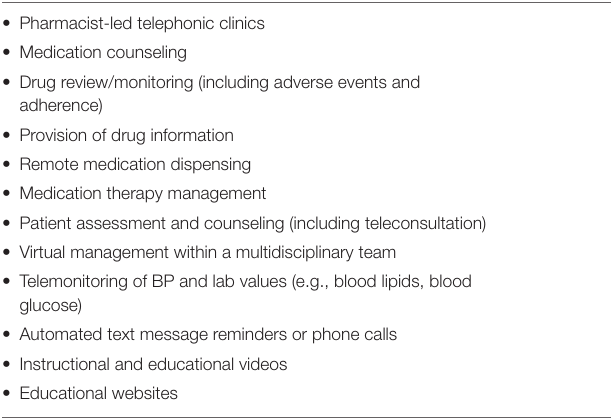
TABLE 3 | Most common currently available telepharmacy services for hypertension